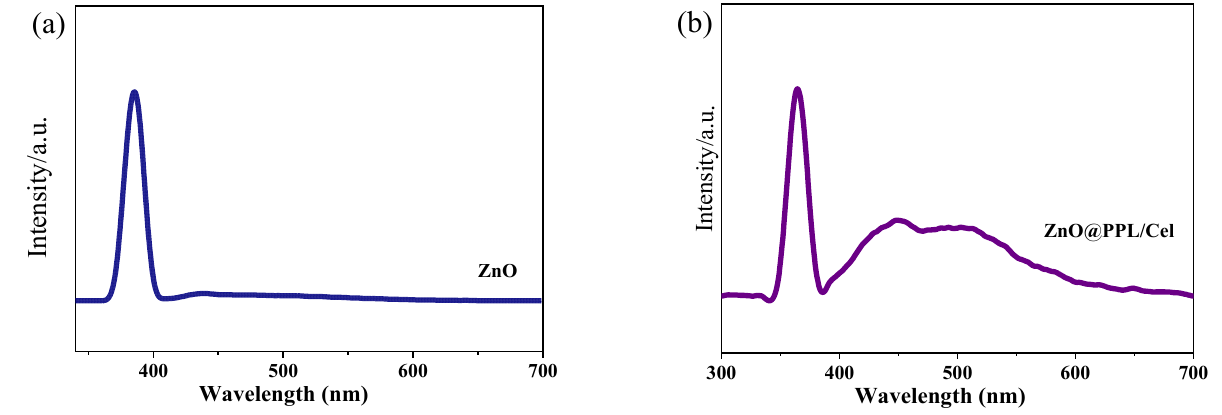
Figure 6. Photo luminescence spectra, ( a ) ZnO and ( b ) ZnO@PPL/Cel.